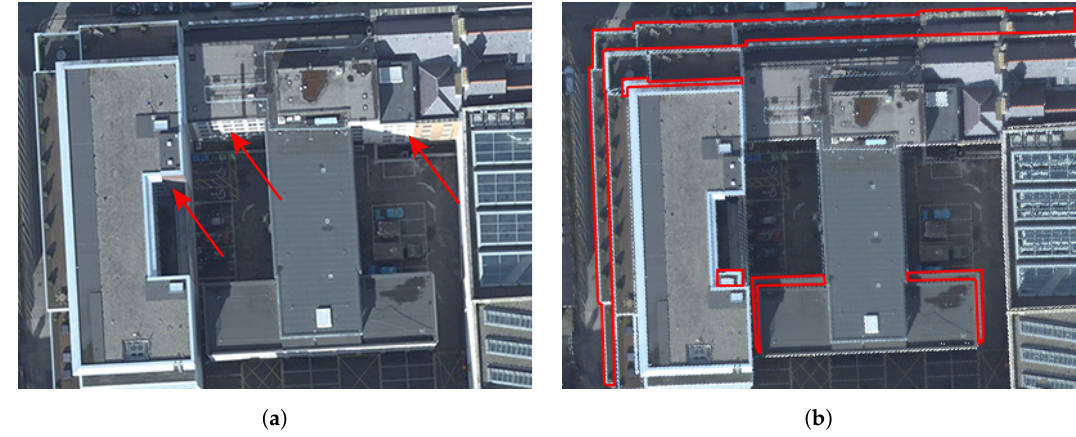
Figure 2. ( a ) Part of a perspective image where the red arrows indicate relief displacements along the facades, and ( b ) the corresponding orthophoto with double-mapped areas enclosed by the red outlines. To produce a true orthophoto, DSM cells occluded in each image need to be identified through an occlusion detection process. Spectral information can then be assigned to orthophoto pixels corresponding to the occluded DSM cells from conjugate areas in adjacent images through a mosaicking process. Developing an efficient algorithm for occlusion detection has been the research topic